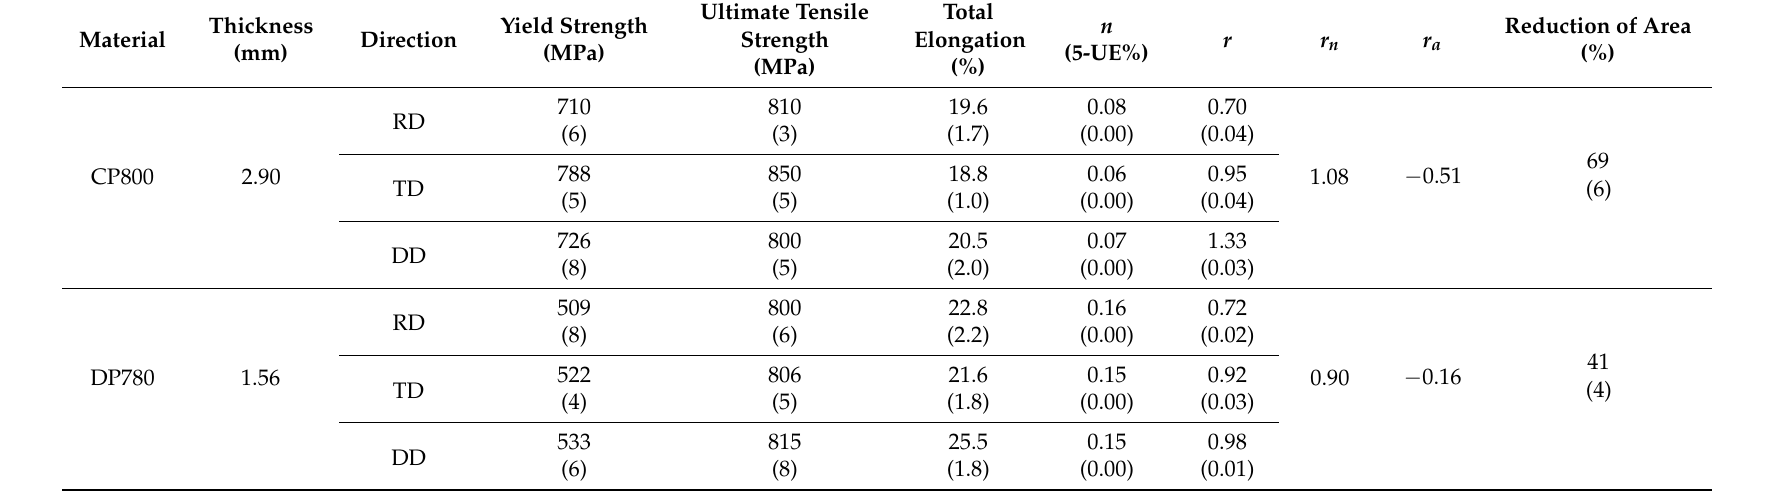
Table 2. Mechanical properties of the CP and DP steels. The value in the brackets is the standard deviation after three tests [7].